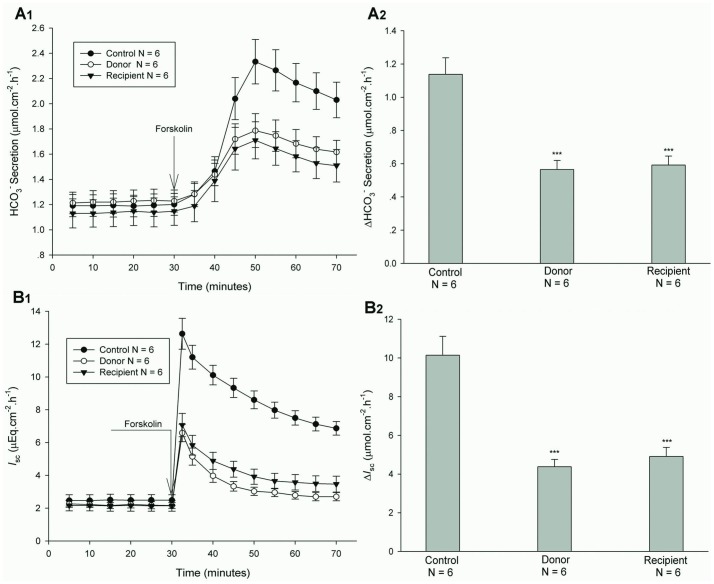
Change of CFTR function after jejunal transplantation in mice.A1 represents time course of HCO3
– secretion and A2 represents ΔHCO3
–. B1 represents time course of Cl– secretion and B2 represents Δ Cl–. Forskolin (10 µM) was added at the time indicated by the arrow. Values are mean± SEM and n = 6 in each series. Forskolin-stimulated HCO3
– and Cl– secretions in both donor and recipient jejunal mucosae were markedly decreased, compared with controls. *** P<0.001.